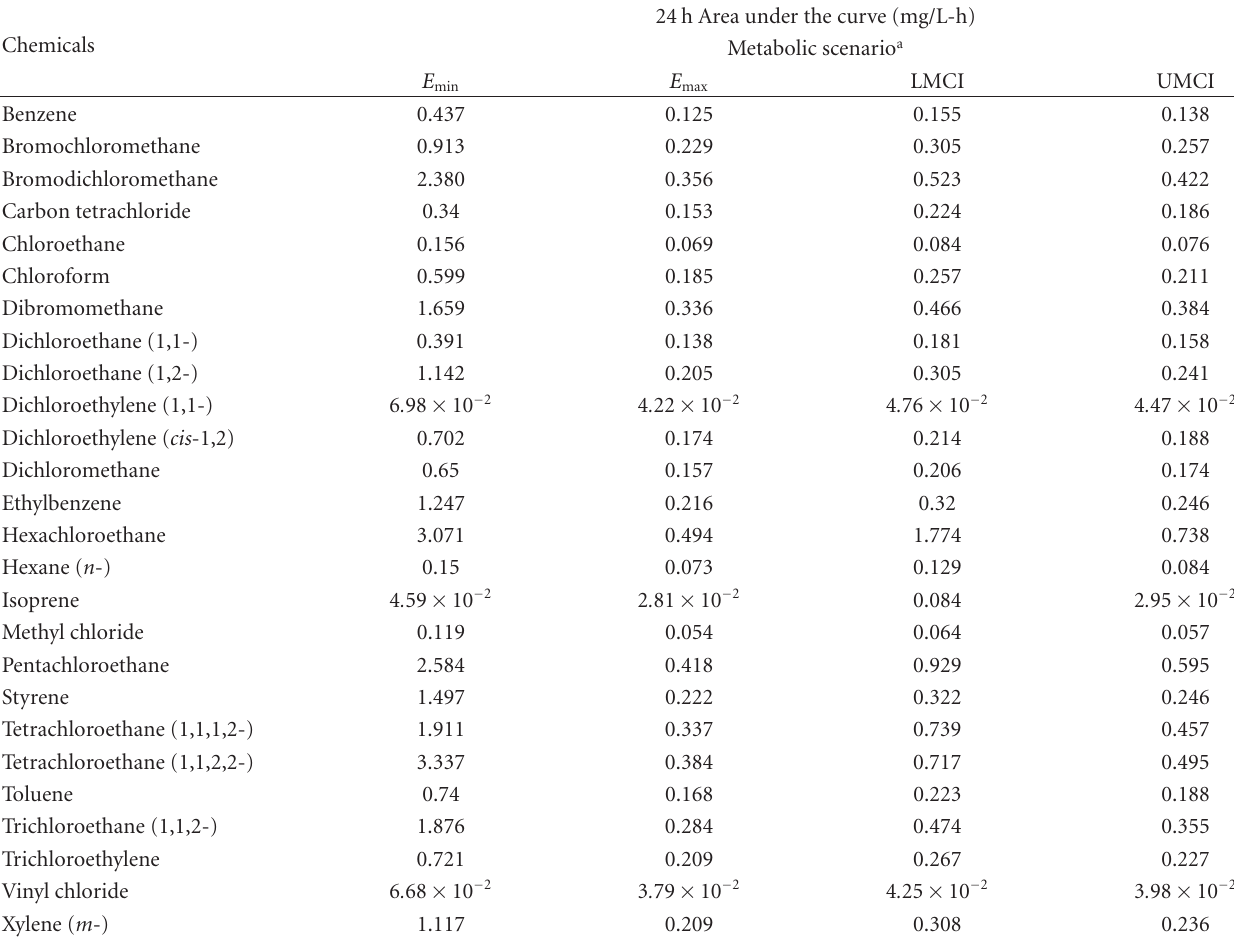
Table 3: Area under the curve for four metabolic scenarios for the VOCs used in the QPPR